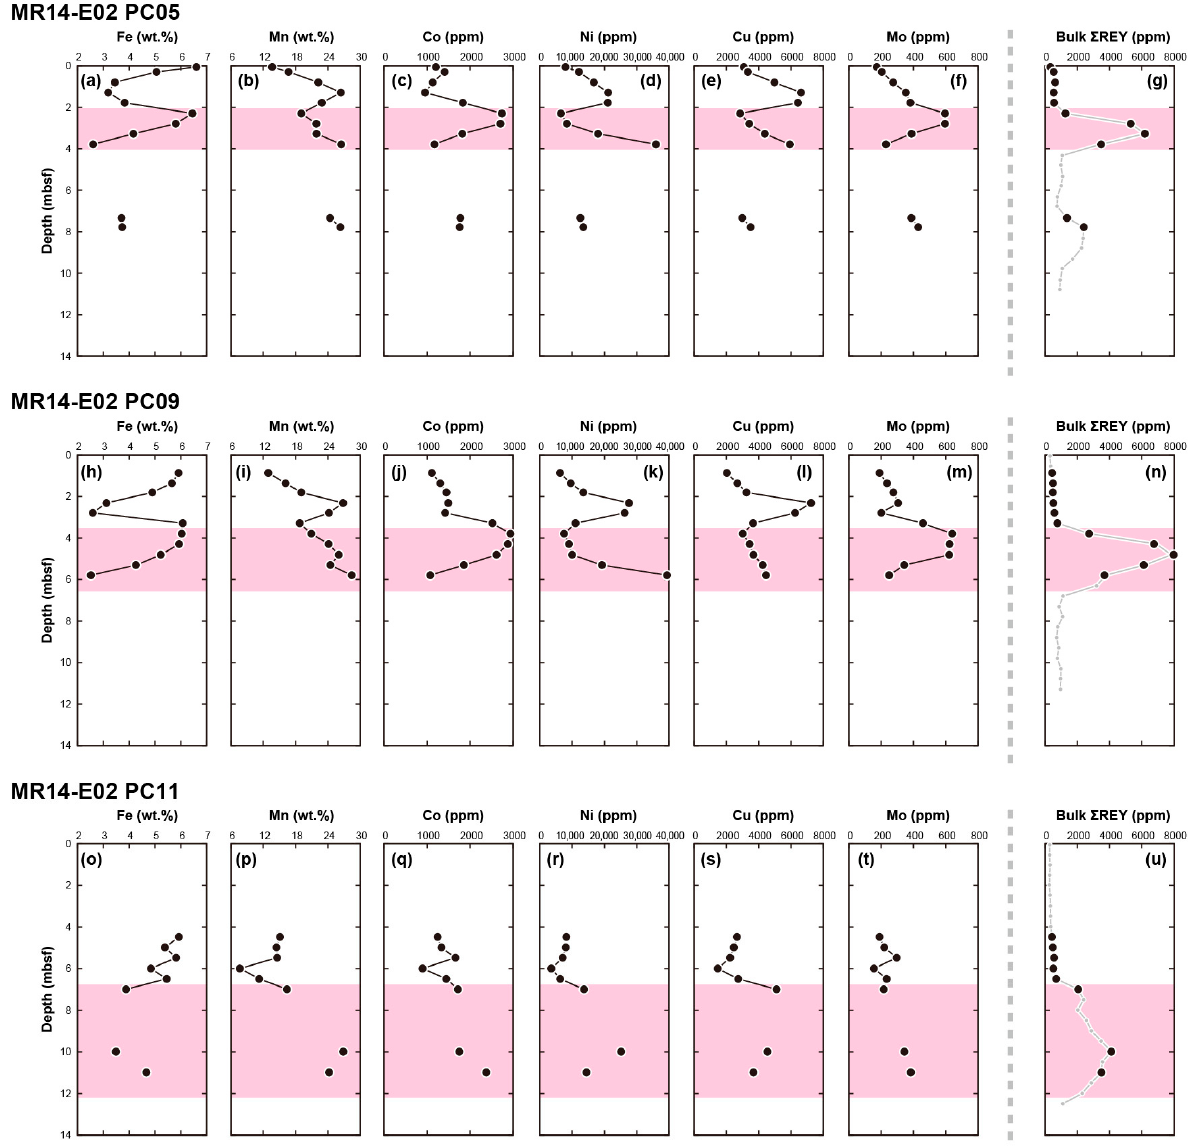
Figure 3. Downcore variations of the key element contents for each piston core. ( a – f , h – m , o – t ) Element contents of the Fe–Mn micronodules (data were obtained from [37]). ( g , n , u ) The Σ REY contents of the bulk sediments are shown in gray [13]. Horizontal pink bars indicate the 1st REY peaks [35]. The black solid circles indicate the horizons from which the Fe–Mn micronodules were collected.